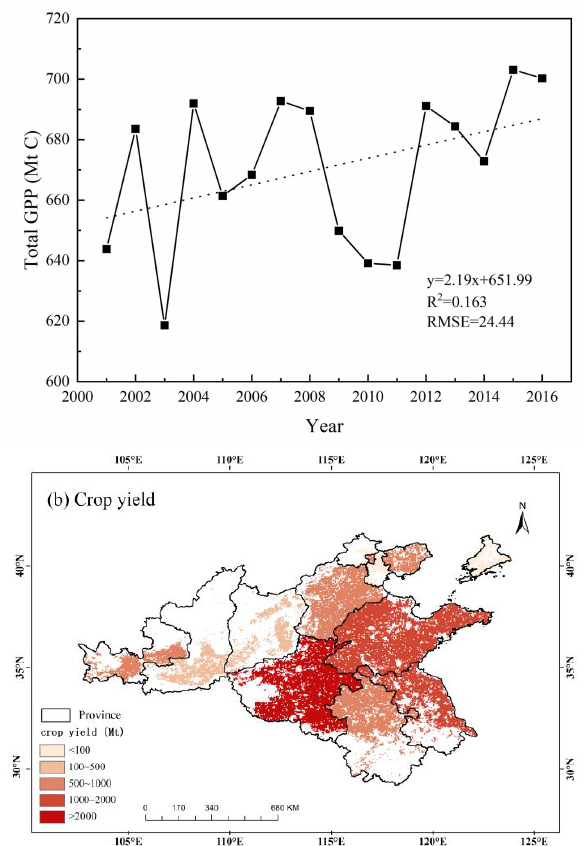
Figure 6 . (a) is inter-annual variation trend of crop yield in the North China Plain from 2001 to 2016. (b) shows the spatial distribution of mean annual total crop yields in the North China Plain from 2001 to